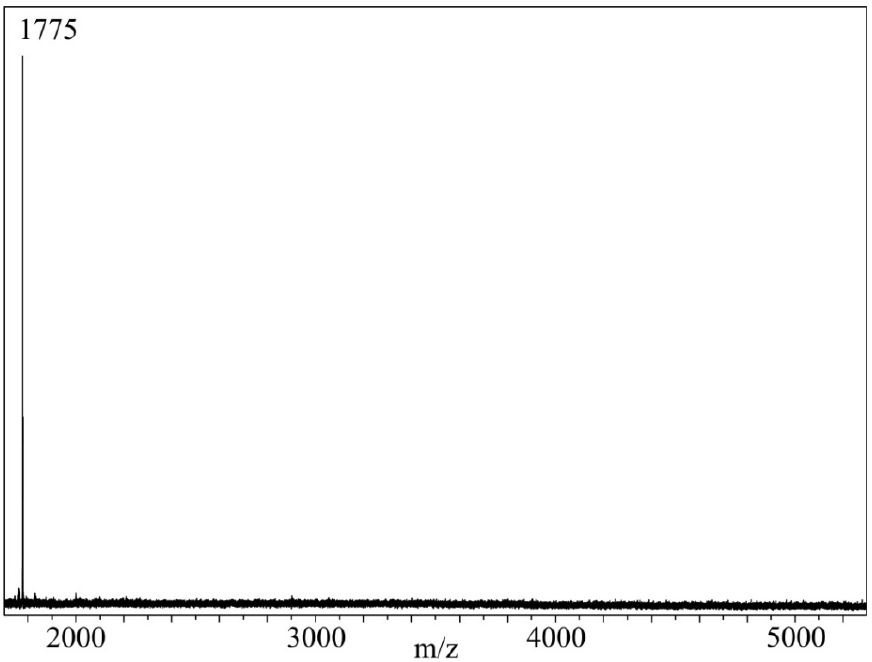
Figure 3. MALDI-TOF mass spectrum of the curing agent containing 30 wt. % FPP in IPDA.